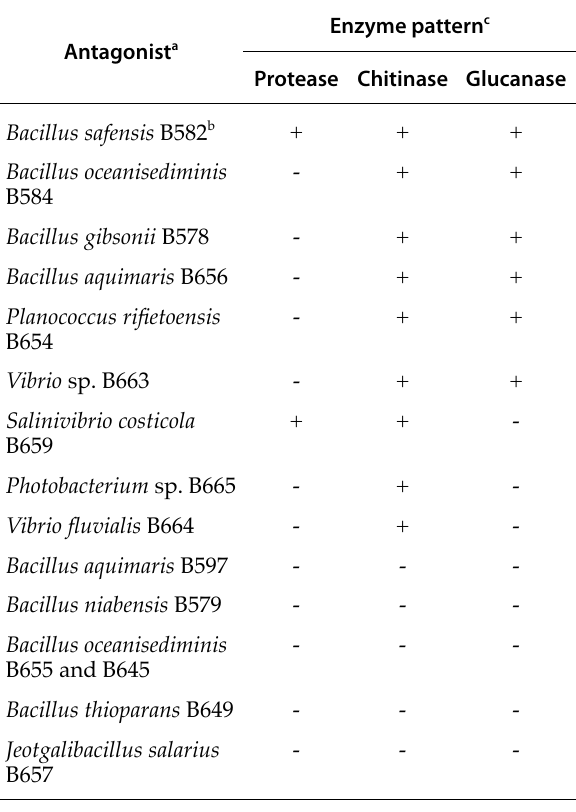
a See Table 1. b See Table 1. c Symbols: +, positive growth; -, no